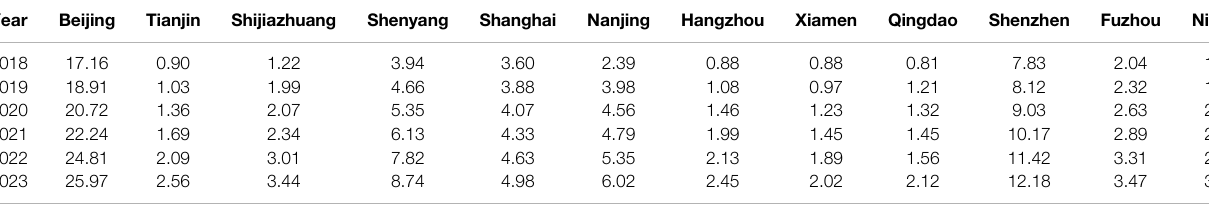
TABLE 7 | Projected trends in urban household gas consumption in the Eastern Region. Year